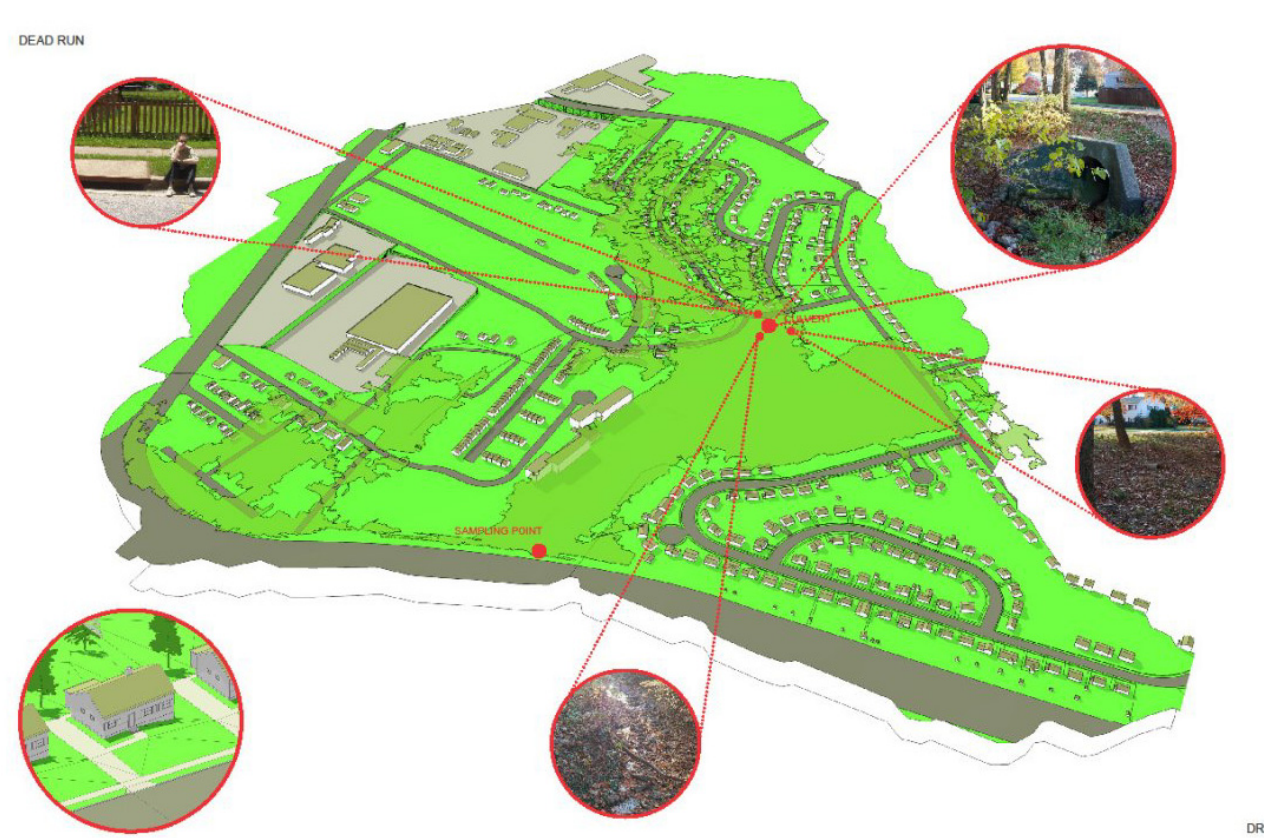
Figure 7. Dead Run is a sub-catchment consisting of mid-20th century suburbs with small ranch houses, strip shopping centers, and neighborhood parks with open streams. The neighborhood has both storm and sanitary sewer systems. (Courtesy of